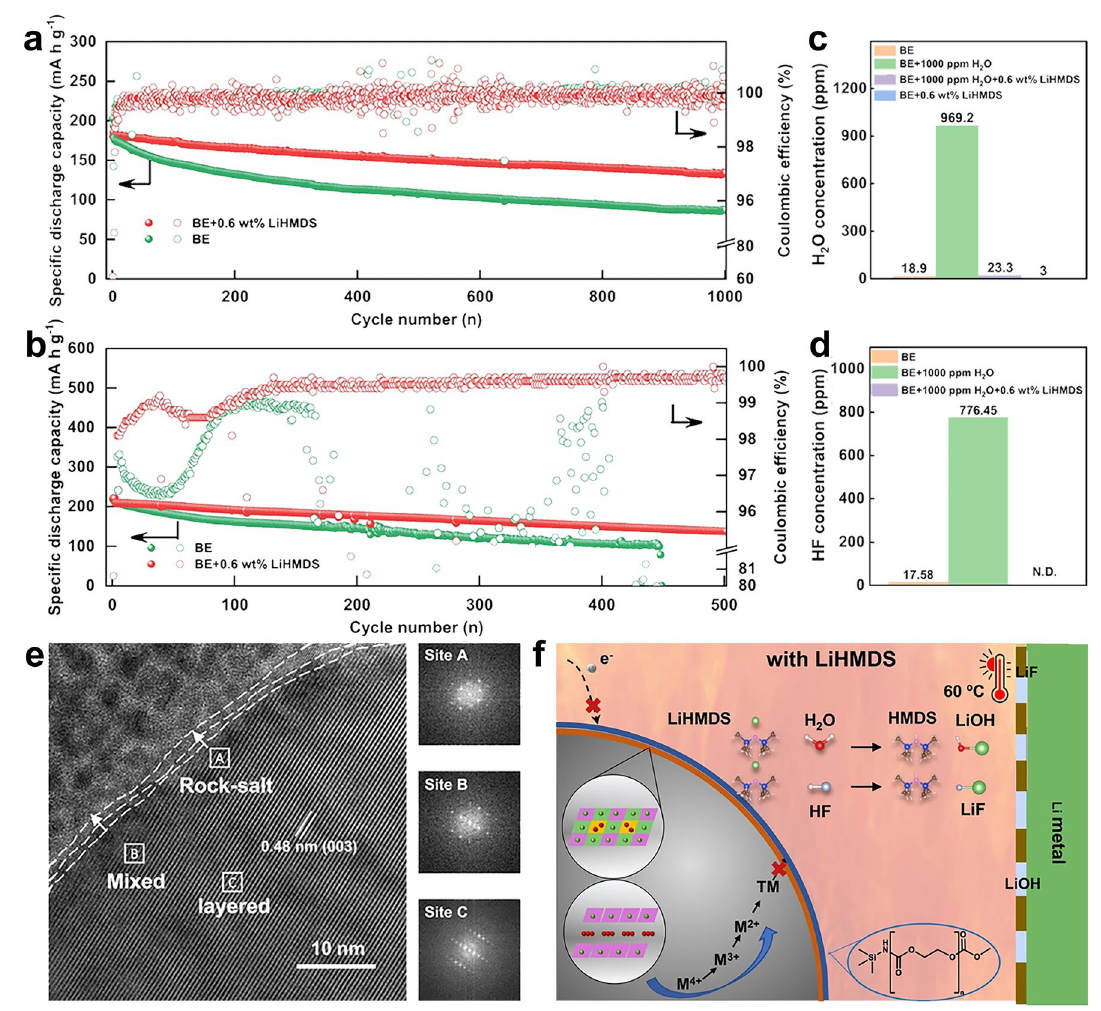
Fig. 1 Cycling performance of Li||NCM811 batteries between 3 and 4.5 V with BE and 0.6 wt% LiHMDS-contained electrolyte a at 25 °C, 90 mAg −1 , b at 60 °C, 180 mA g −1 . c The concentration of H 2 O in BE, BE + 0.6 wt% LiHMDS, BE + 1000 ppm H 2 O and BE + 0.6 wt% LiH- MDS + 1000 ppm H 2 O. d The concentration of HF in BE, BE + 1000 ppm H 2 O and BE + 0.6 wt% LiHMDS + 1000 ppm H 2 O. e Ex-situ TEM image of NCM811 cathode particle after 100 cycles in the electrolyte with 0.6 wt% LiHMDS at 60 °C. f Schematic illustration of LiHMDS with H 2 O and HF in Li||NCM811 cells at 60